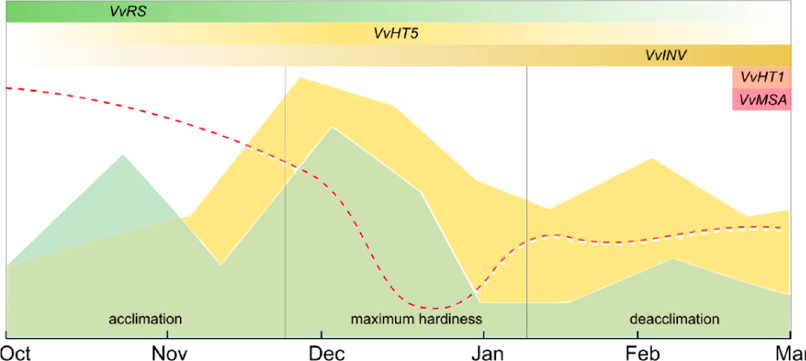
Figure 4. Relationship between sugars accumulation patterns (raffinose in green, hexoses in yellow) and dormancy progression in the grapevine interspecific hybrids UD 31-103. Dashed red line approximately depicts the gain and loss of cold-hardiness during the dormant season (data from [49]). Potential regulatory roles of genes at different stages are shown in boxes. The trends are purely indicative and irrespective of the quantitative relationships among the various parameters.